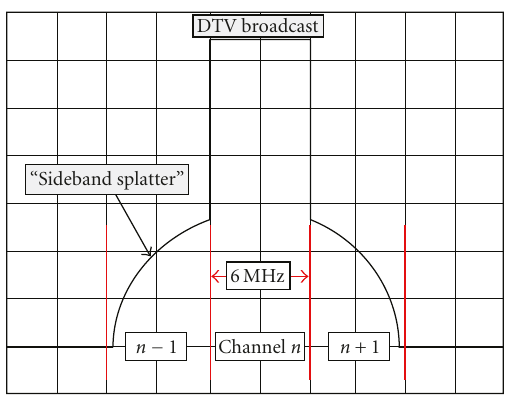
Figure 1: Adjacent Channel Interference.